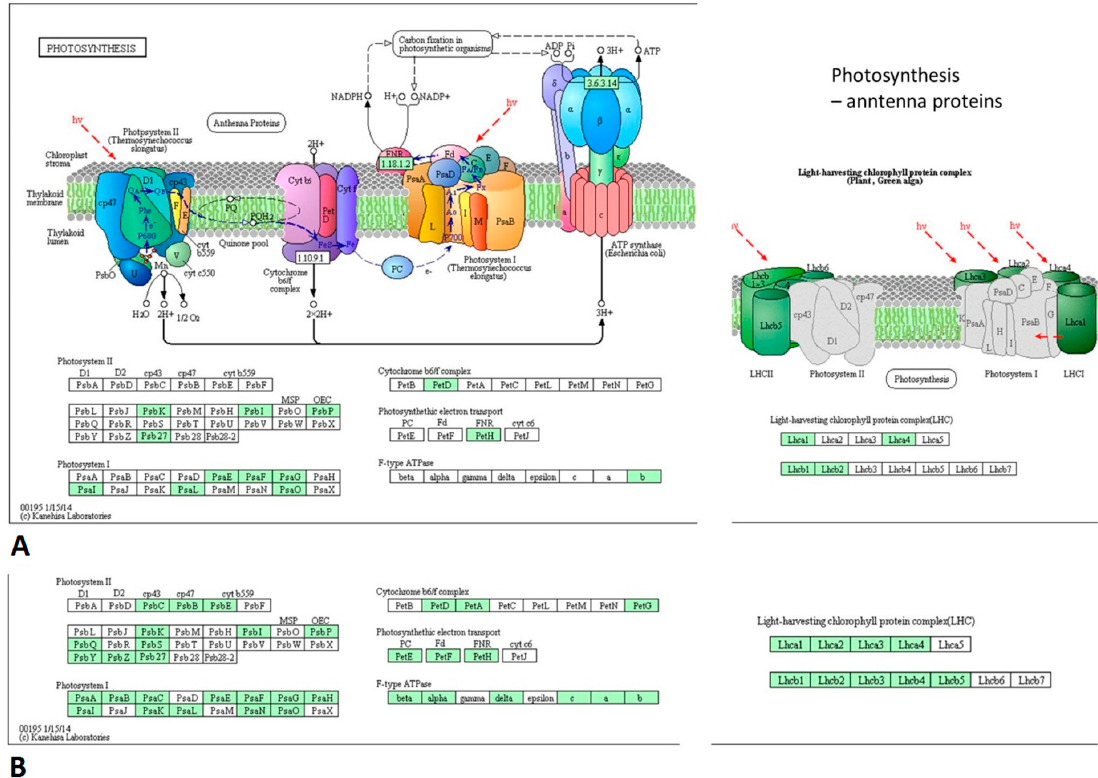
Figure 9. Down-regulated DEGs (marked in green) associated with photosynthesis (left) and antenna proteins (right). ( A ) PSV-G infected plants; ( B ) PSV-G + satRNA-co-infected plants. Visualization was obtained from KAAS [35].